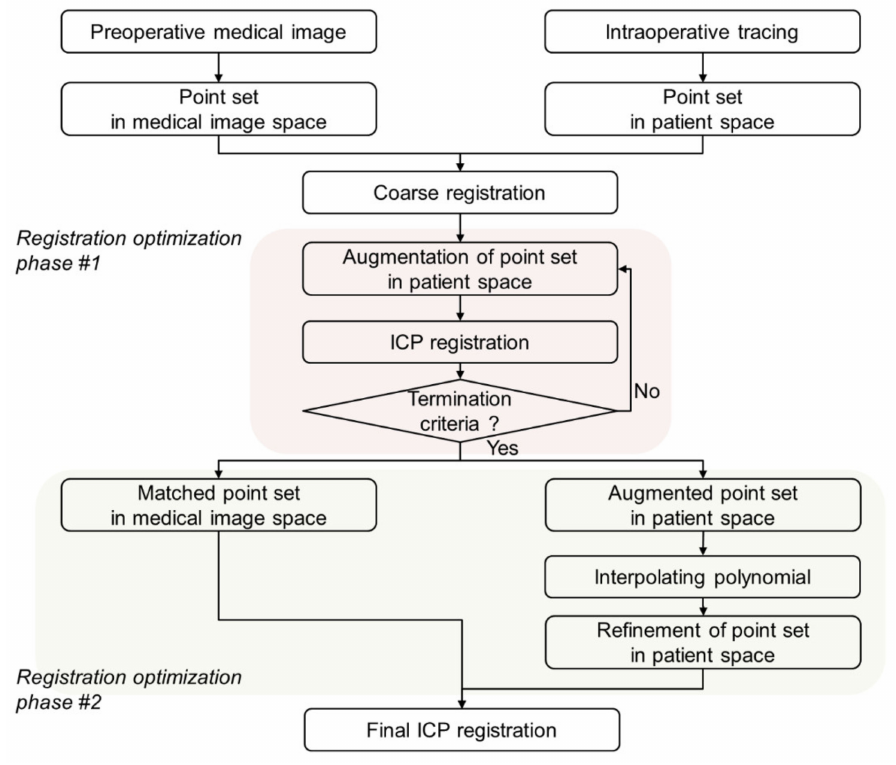
Figure 1. Workflow of the proposed registration